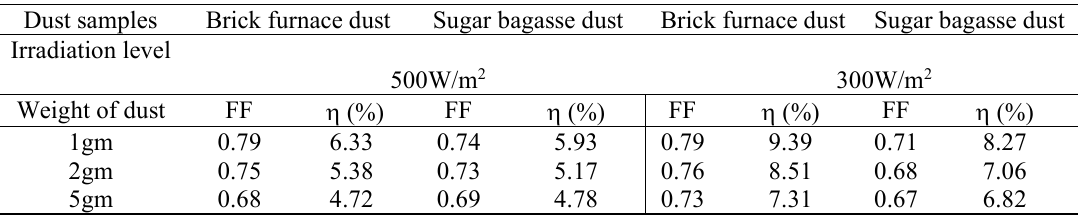
Table 10. Comparison of FF and efficiency for different dust samples and weights with reflector